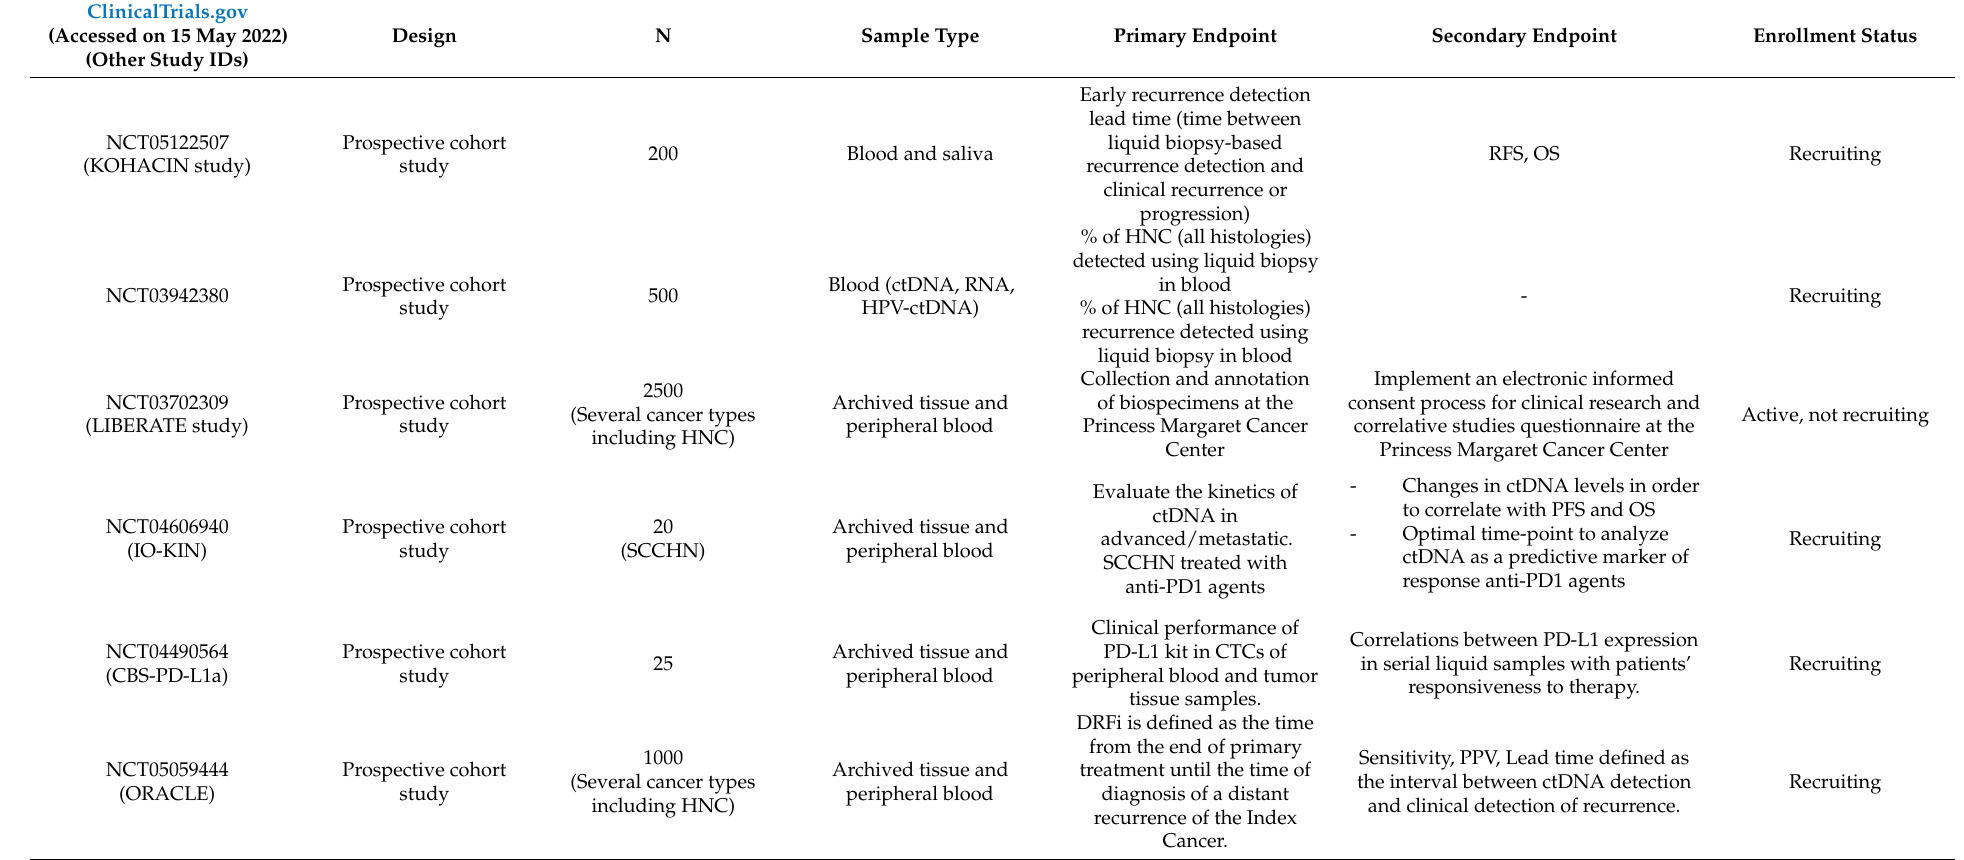
Table 6. Current ongoing studies evaluating the role of liquid biopsy in head and neck